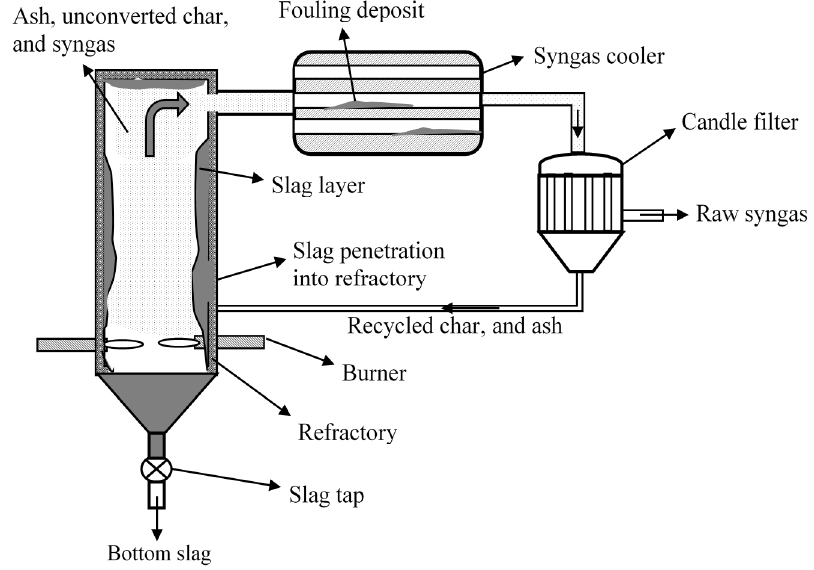
Figure 6. A pictorial representation of an entrained flow gasifier with some mineral matter